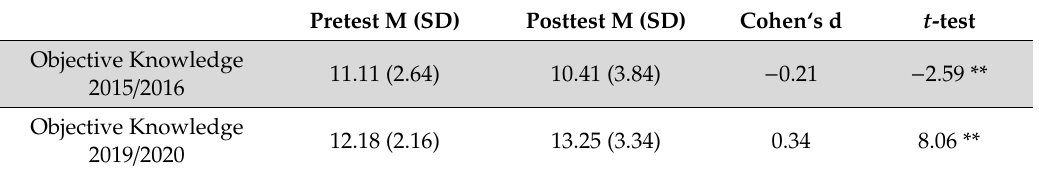
Table 4. Mean Value Comparison of Objective Knowledge Using Cohen’s d and t